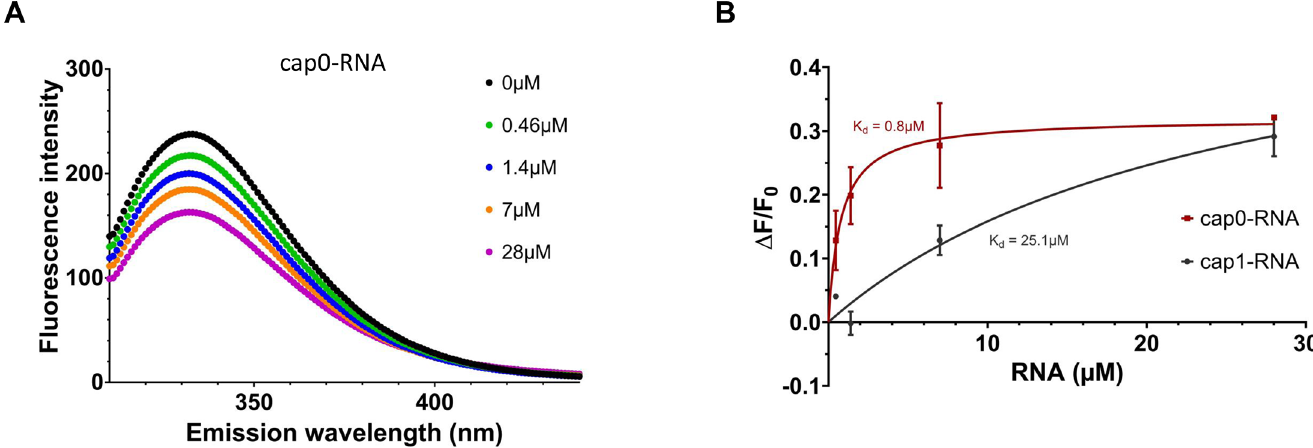
Fig 3. The presence of a 2’- O -methylation decreases affinity of DXO for capped RNA. The affinity of DXO for cap0-RNA and cap1-RNA were measured using fluorescence spectroscopy. (A) Increasing amounts of cap0-RNA (0.46μM– 28μM) were added to a of 1.2μM solution of DXO, and the emission spectrum was scanned from 310 to 440nm. (B) A saturation isotherm can be generated from these data by plotting the change in fluorescence intensity at 332nm as a function of added RNA. Results are shown as changes in intrinsic fluorescence in the presence of capped RNA compared to the absence of RNA ( Δ F/F 0 ).